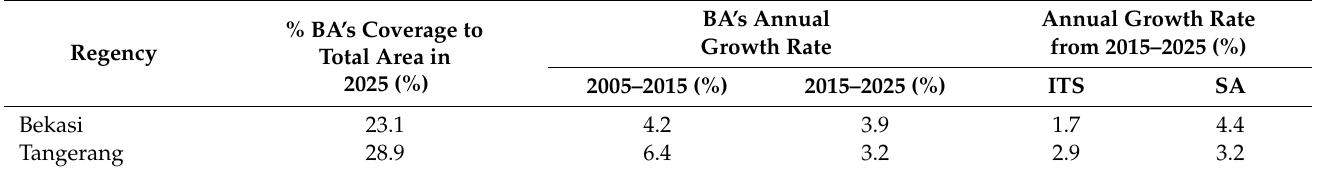
Table 7. Built-up area (BA) coverage and annual growth